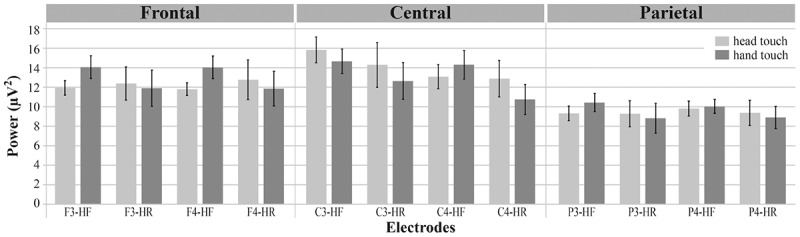
Grand average EEG power across mu frequency band (6–8 Hz) for electrodes of interest (F3, F4, C3, C4, P3, P4) in response to hand touch (dark gray) and head touch (light gray) for both hands-free (HF) and hands-restrained (HF) condition. Error bars represent standard errors of the mean.